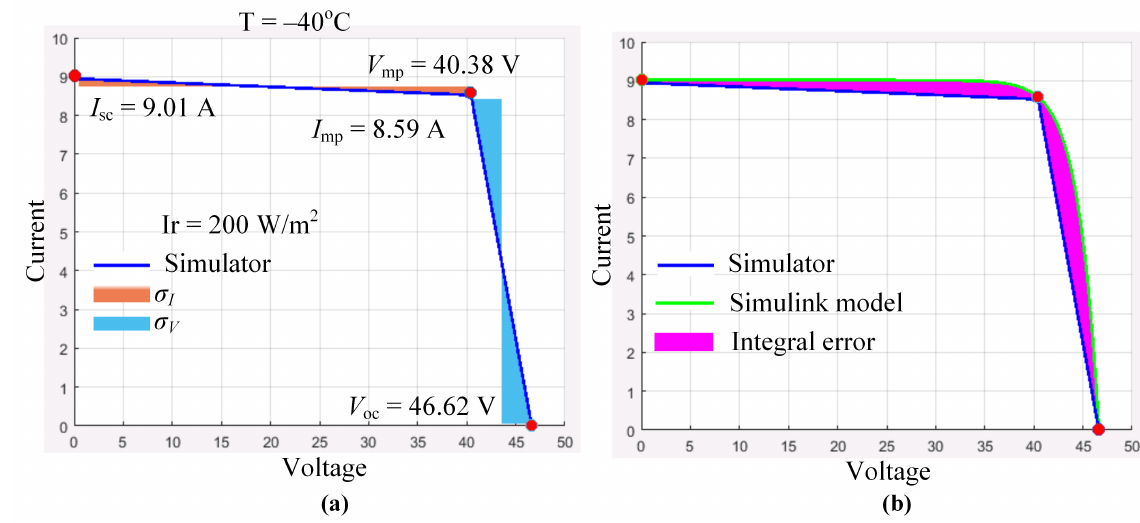
Figure 12. Rendering the standard deviations ( a ) and integral error ( b ) on I-V curves.